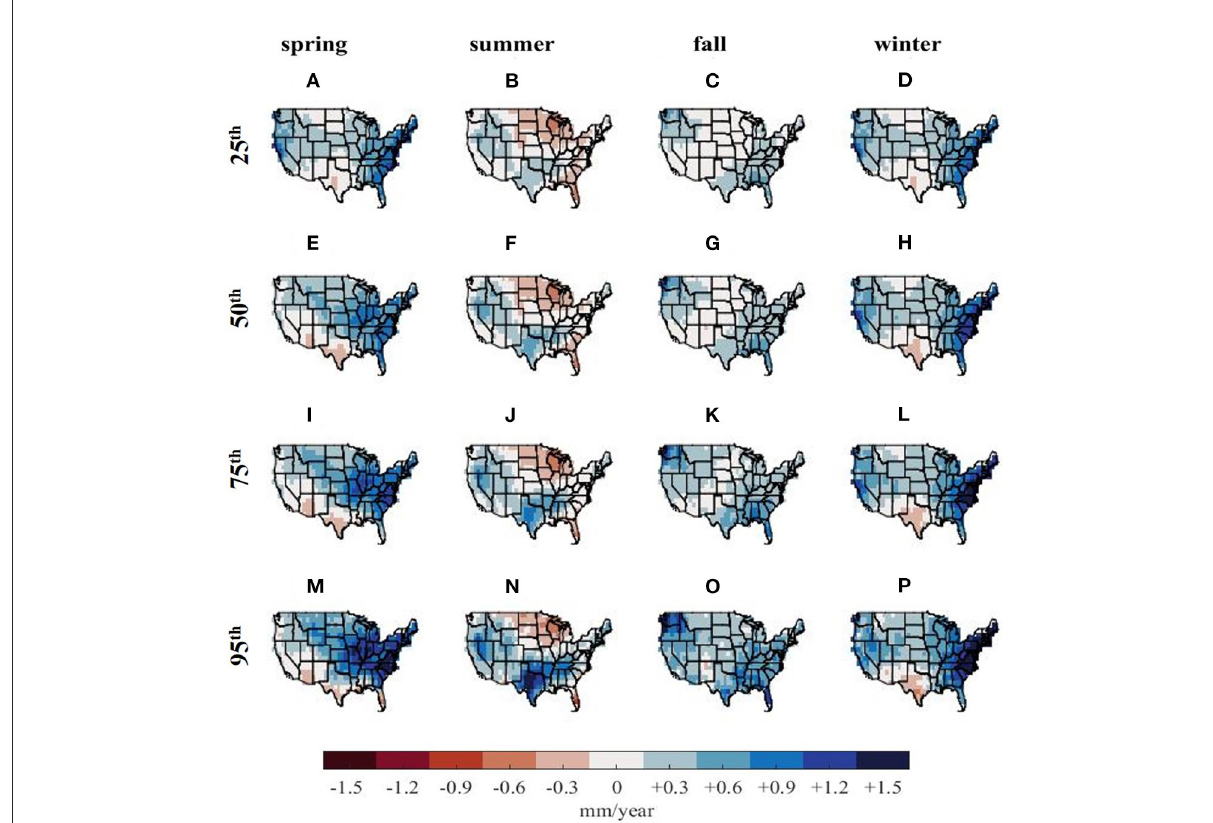
FIGURE3 CONUS spatial distribution of projected seasonal total (mm/year) Sen’s long-term trends of projected seasonal total (mm/year) from 2015 to 2100 using CESM2-LE for different quantiles (rows) across seasons (columns). Cold (blue) colors represent wetting trends, whereas warm (red) represents a drying trend, and no change is highlighted in the white color. The trend magnitudes are shown as; lower 25th [spring (A) , summer (B) , fall (C) , and winter (D) ; median, 50th, (E–H) ; above median 75th, (I–L) ; and extreme 95th (M–P)